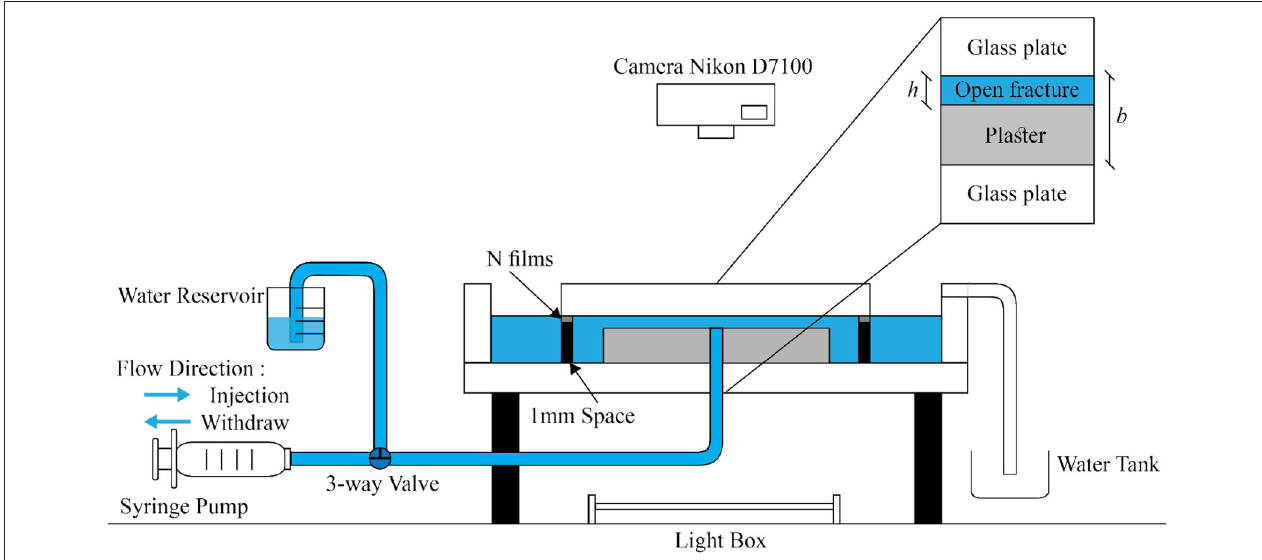
FIGURE 1 | Schematic diagram of experimental setup, see description in the text. A plaster plate with a small gap h above the plaster upper surface is placed in a circular Hele Shaw cell (spacing b 1 mm ). The aperture h is created artificially by inserting thin plastic films between the plaster and the top plate. A syringe pump = injects or withdraws fresh water with flow rate Q from the center of the bottom glass plate (the inlet/outlet), where it flows radially inwards or outwards. The syringe can be connected to a water reservoir by a 3-way valve to recharge the syringe and ensure continuity of the flow. A light box illuminates the model from below.